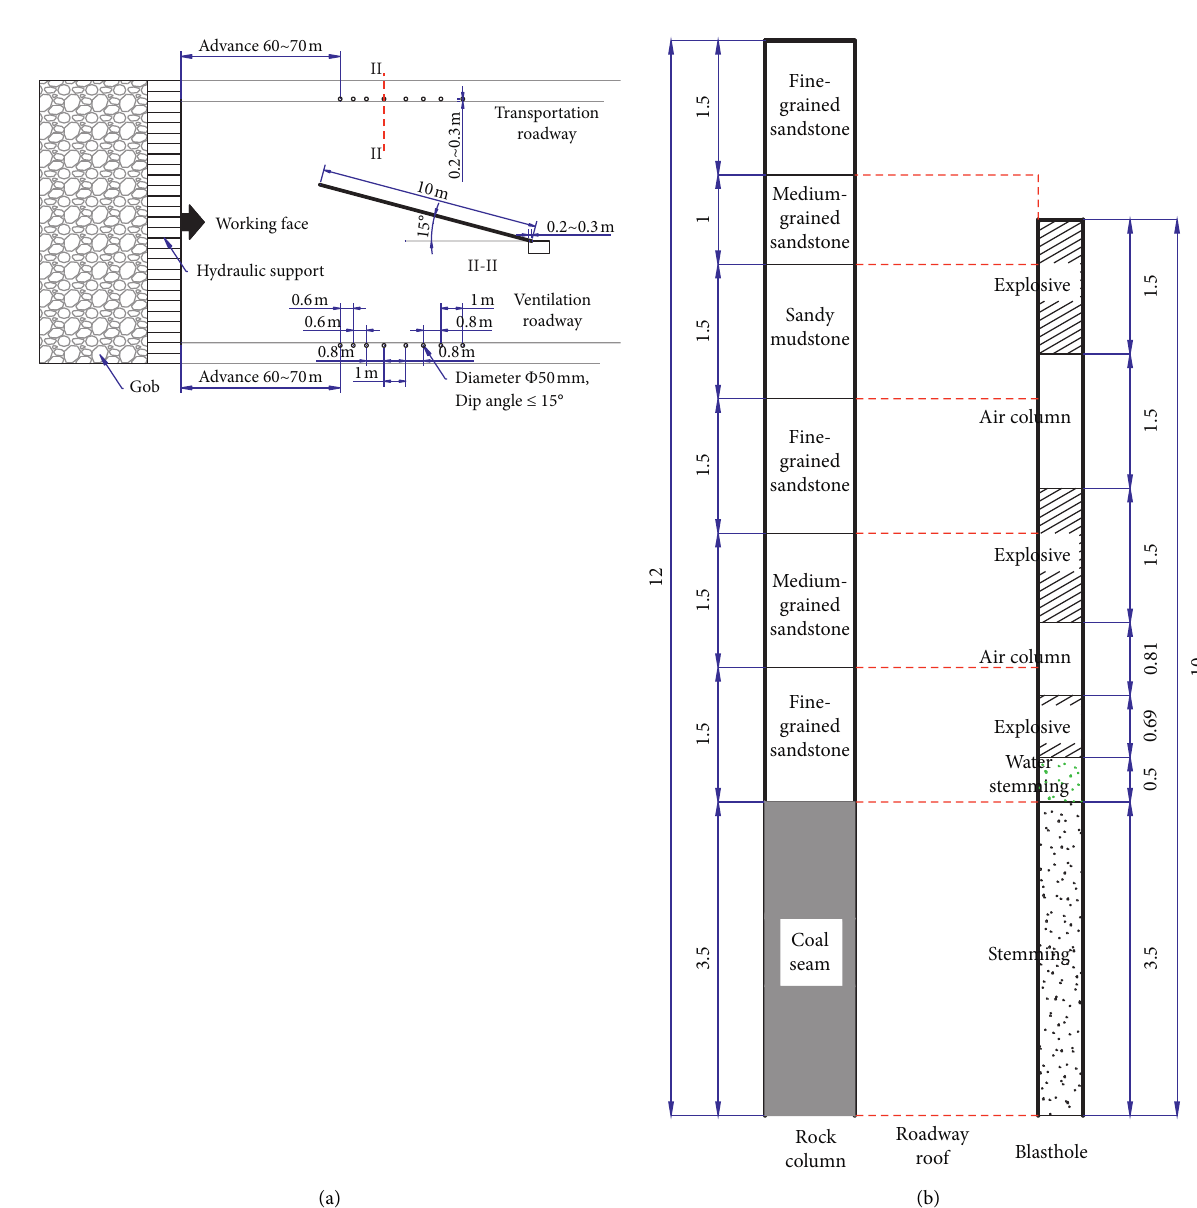
Figure 13: Blasting layout of the roadway roof. (a) Blasting layout of the roadway roof. (b) Charge